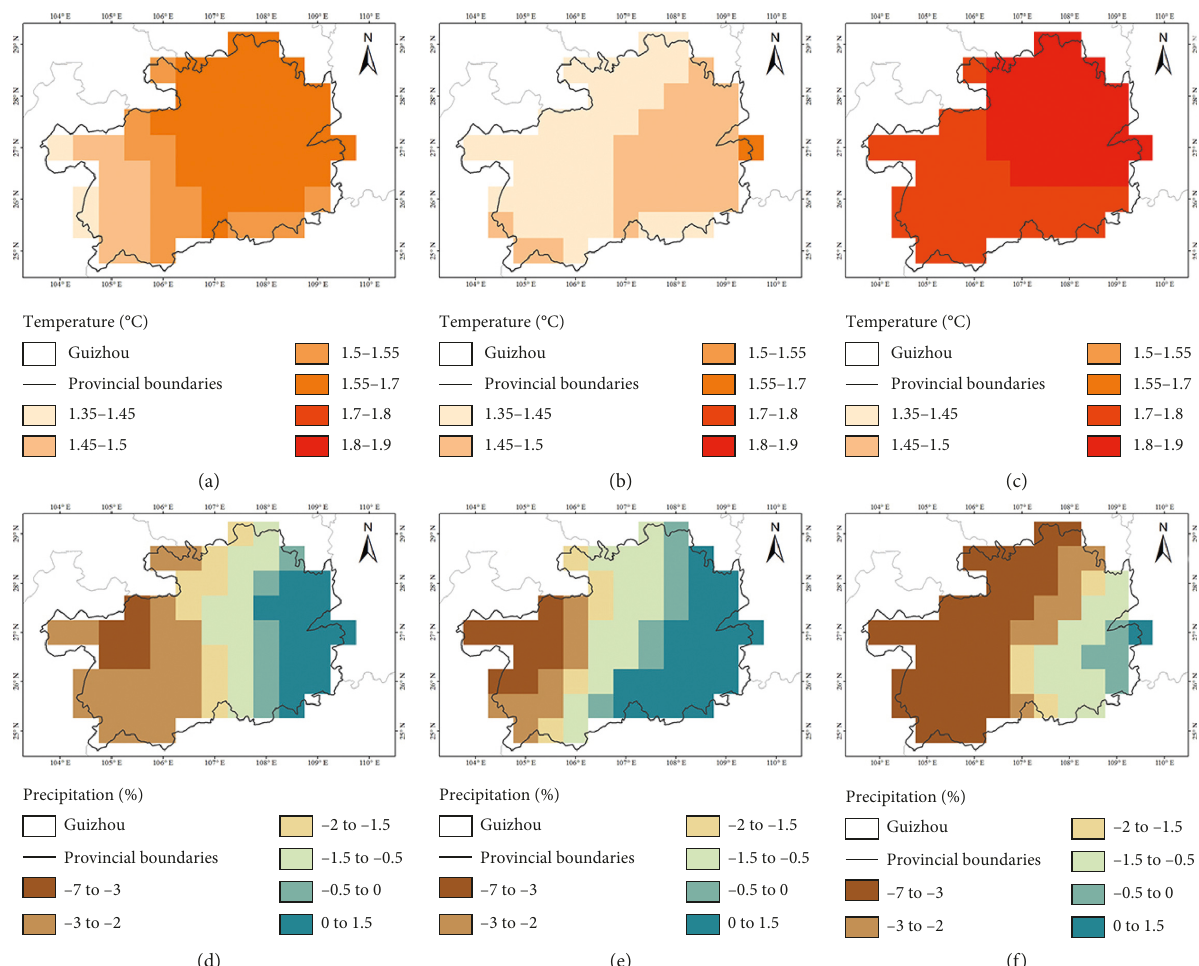
Figure 12: Change of annual average temperature and annual precipitation from 2019 to 2050 compared with the baseline period in Guizhou. (a) RCP2.6. (b) RCP4.5. (c) RCP8.5.